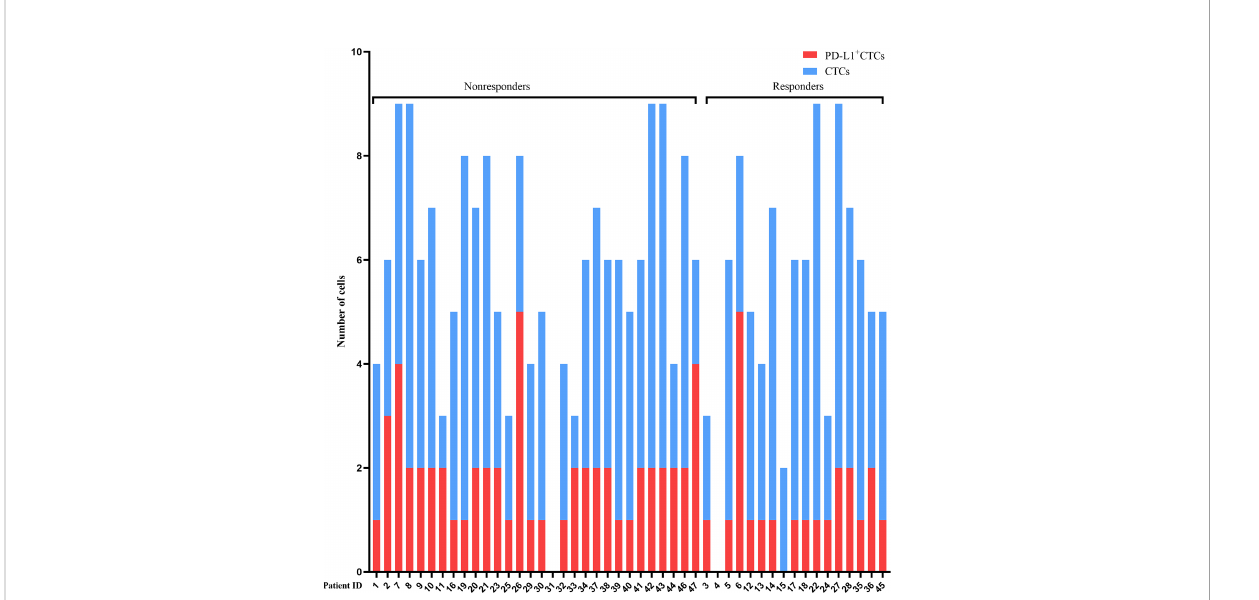
FIGURE 1 Detection of CTCs and PD-L1 + CTCs. The counts of CTCs (blue bars) and PD-L1 + CTCs (red bars) per patient detected are presented at baseline. Nonresponders and responders were divided into two groups. PD-L1, programmed death-ligand 1; CTCs, circulating tumor